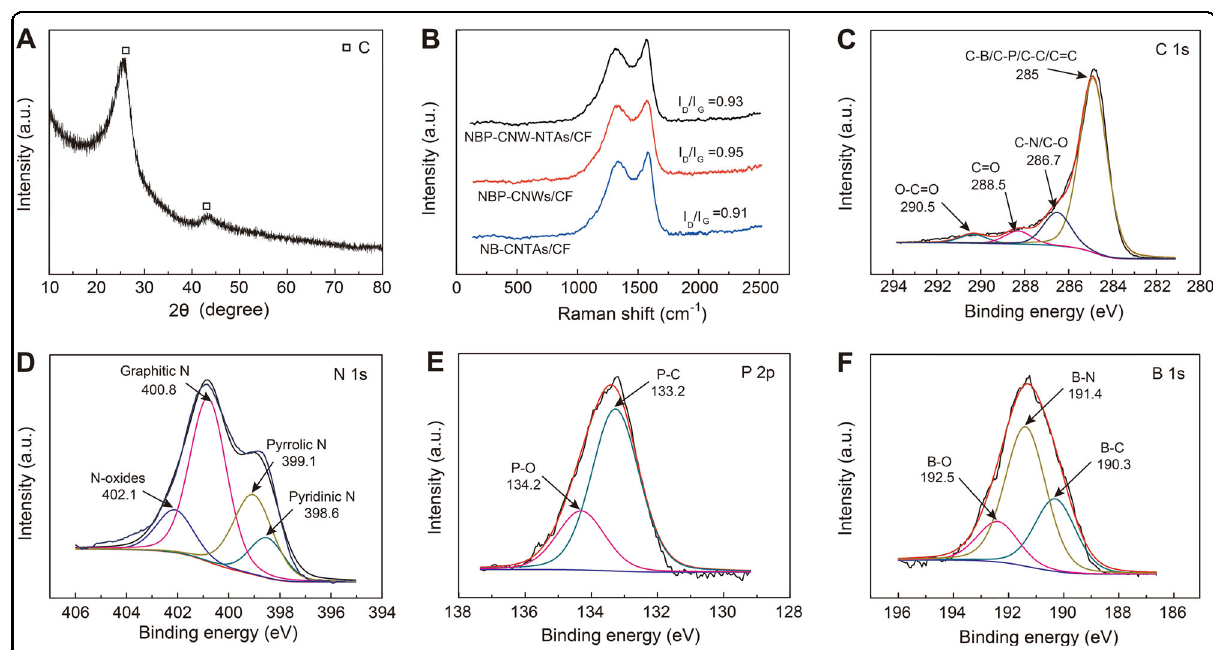
Fig. 2 The structure and composition characterization of NBP-CNW-NTAs. A XRD of NBP-CNW-NTAs. B Raman spectra of NBP-CNW-NTAs, NBP-CNWs and NBP-CNTAs. High-resolution XPS spectra of ( C ) C 1 s, ( D ) N 1 s, ( E ) P 2p and ( F ) B 1 s of